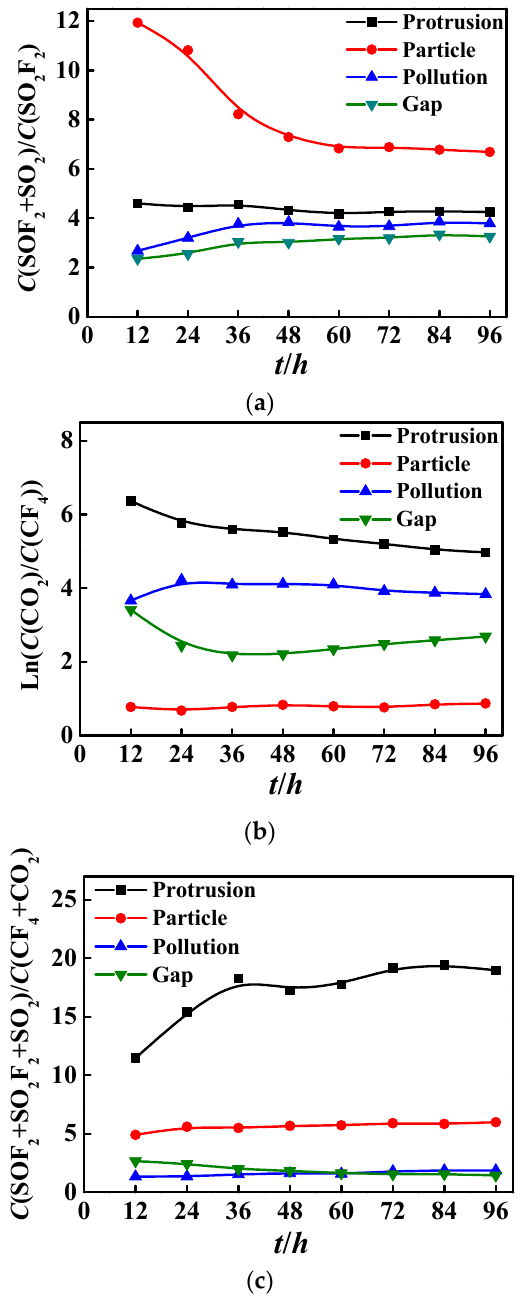
Figure 8. Change curves of the concentration ratios of SF 6 decomposed components with time: ( a ) C (SOF 2 )/ C (SO 2 F 2 ); ( b ) Ln ( C (CO 2 )/ C (CF 4 )); and ( c ) C (SOF 2 + SO 2 F 2 + SO 2 )/ C (CF 4 + CO 2 ).